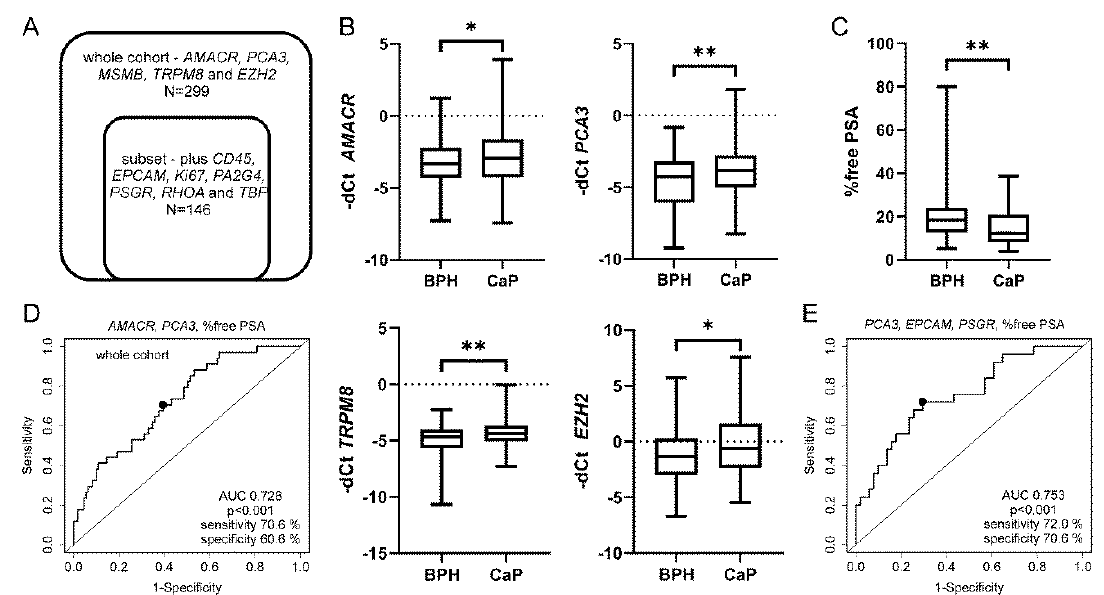
Figure 1. Urine markers are differentially expressed between CaP and BPH. ( A ) Description of the whole cohort and a subset of patients analyzed for indicated transcripts. ( B ) AMACR, PCA3 , TRPM8 and EZH2 expression were significantly different for CaP and BPH patients ( p values 0.045, 0.004, 0.005 and 0.019, respectively). ( C ) Percentage of free PSA in combination with urine markers contribute to discrimination of BPH from CaP. Percentage of free PSA significantly discriminates CaP from BPH ( p value 0.003). Box-plots represent median, 25 – 75% percentiles and range of values. P-values <0.05 and <0.01 are indicated by * and **, respectively. ( D ) Receiver-operating characteristic analysis for % free PSA in combination with urinary markers AMACR and PCA3 or ( E ) with EPCAM, PCA3 and PSGR in the subset of patients. Table 1. Patients characteristics.